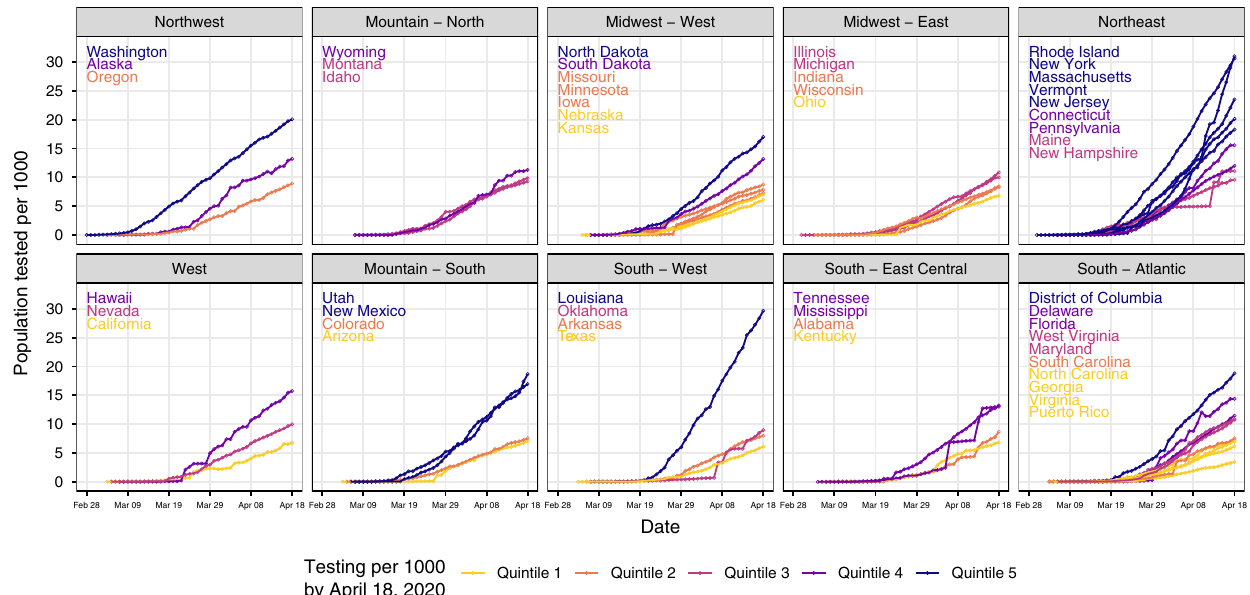
Fig. 1 Daily SARS-CoV-2 tests per 1000 population in the United States by state and region. SARS-CoV-2 testing rates in US states increased from close to 0 in early March to 6 per 1000 in Kansas to 31 per 1000 in Rhode Island by April 18, 2020. Generally, testing rates were higher in the Northwest and Northeast and lower in the Midwest and South. We estimated the cumulative population tested in each state by date by dividing the number of tests performed by 2019 population projections from the U.S. 2010 Census. Each open circle indicates the number of individuals tested in a state on a given day per 1000. Line, point, and text colors are based on quintiles of the distribution of testing per 1000 population on April 18, 2020 across all states. Testing quintile from lowest to highest is mapped to color from warmest to coolest (such that quintile 1, the lowest, maps to yellow (warmest), and quintile 5, the highest, maps to dark purple (coolest)). In each panel, state names are sorted in descending order by the population tested per 1000. Quality of daily estimates of the number of tests performed varied by state; see Supplementary Table 3 for details. See interactive plot at https://covid19epi.github.io/